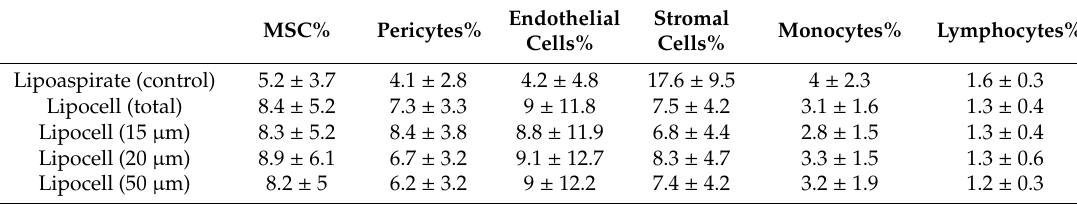
Table 1. Percentages of ATD-MSCs, pericytes, and other stromal vascular fraction (SVF) subpopulation in Lipocell-treated and untreated